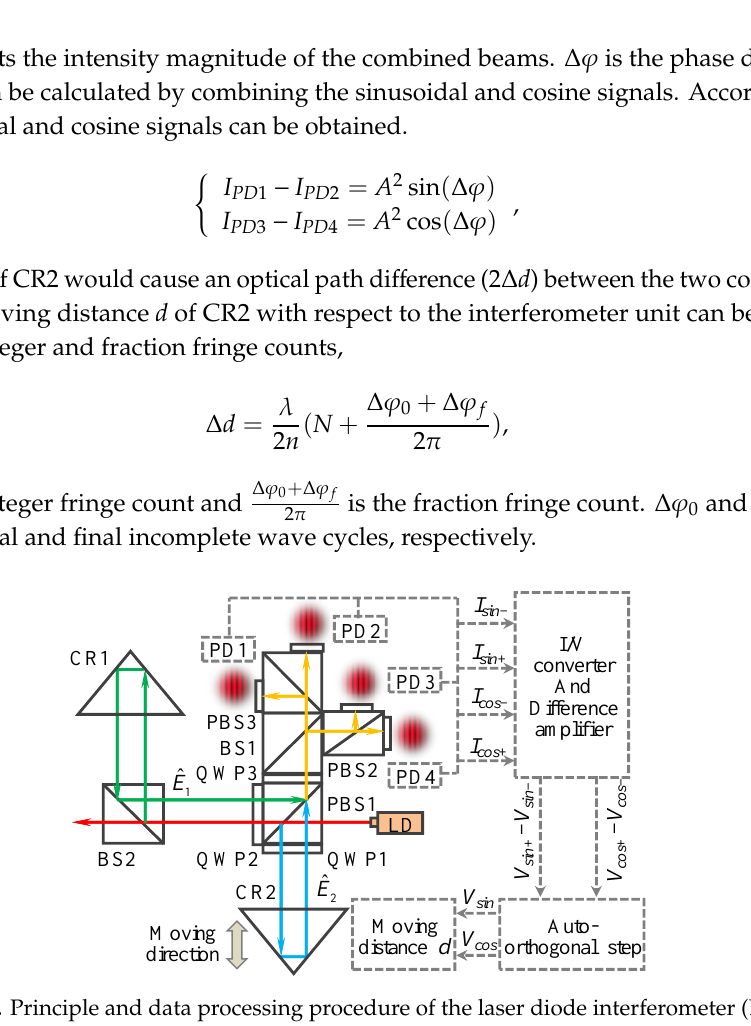
Figure 2. Principle and data processing procedure of the laser diode interferometer (LDI).